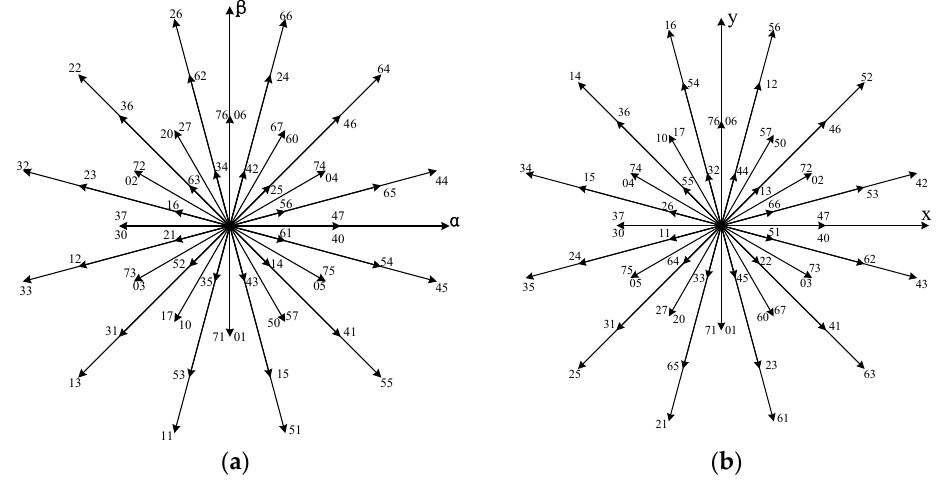
Figure 2. Dual three-phase two-level inverter.